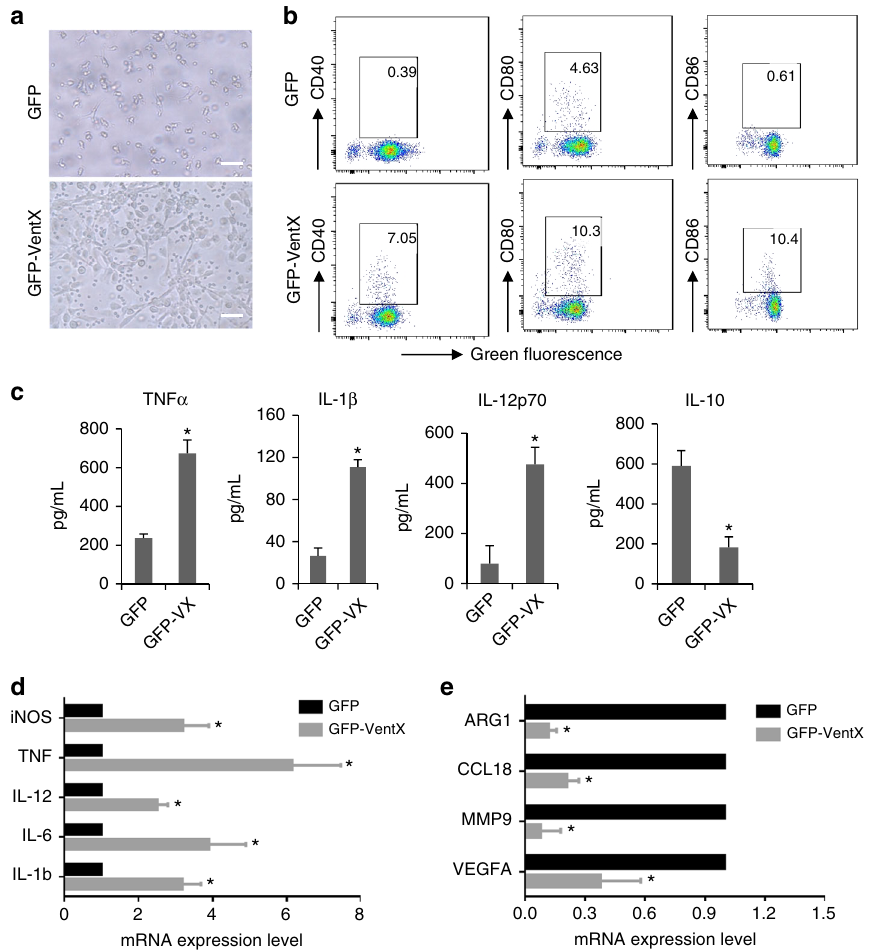
Fig. 3 VentX polarizes TAMs towards M1 phenotype. a Morphology of TAMs transfected with GFP or GFP-VentX. Scale bar: 20 μ m. b Surface expression of CD40, CD80, and CD86 in TAMs transfected with GFP or GFP-VentX as determined by fl ow cytometry analysis. Representative data of three independent experiments were shown. c ELISA measurement of secretion of pro-in fl ammatory cytokines in TAMs transfected with GFP and GFP-VentX. Results represent mean ± SD of four independent experiments and paired Student ’ s t -test was used. Expression of M1 ( d ) and M2 ( e ) macrophage markers in TAMs transfected with GFP or GFP-VentX as determined by qRT-PCR. Data shown are mean ± SD of three independent experiments and paired Student ’ s t -test was performed. * p <